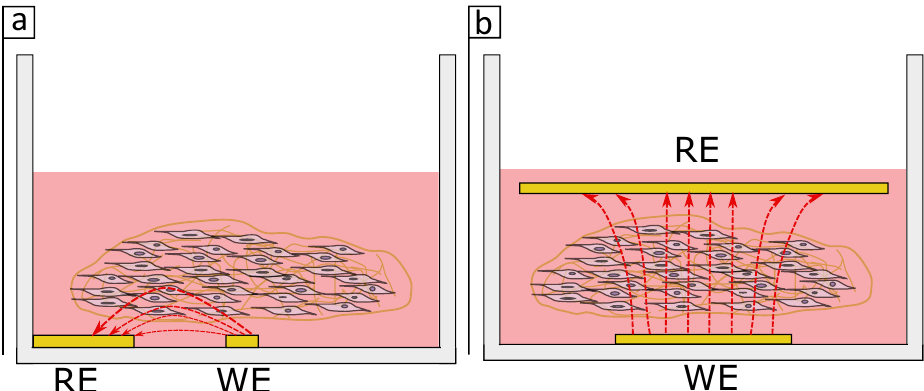
Figure 9. Schematic drawing showing the current flow (red arrows) between working electrode (WE) and reference electrode (RE) when the collagen gel is in an ( a ) in-plane or in a ( b ) parallel electrode setup.